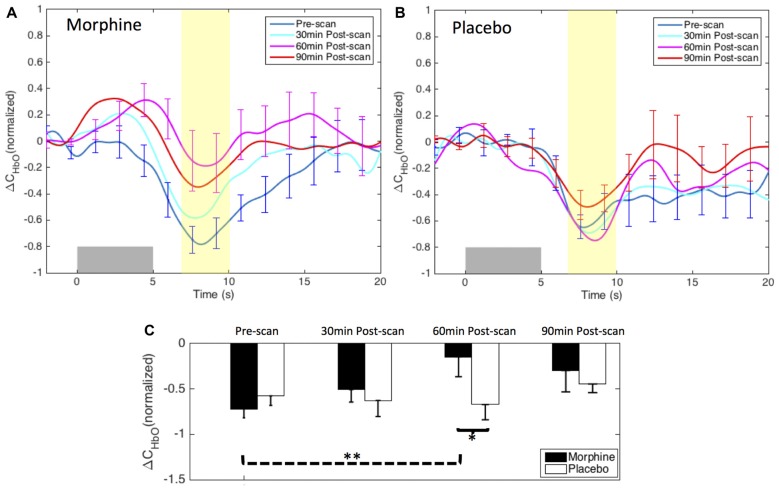
Morphine and Placebo effects on noxious stimuli in medial BA 10. Top panel: the normalized HRFs to noxious stimuli (VAS7) over the medial BA 10 during visits in which (A) oral morphine or (B) placebo was administered. Gray bars indicate the time period when noxious electrical stimuli were applied. Bottom panel: (C) bar plots of the averaged HRF magnitudes (from 7 s to 10 s post-stimulus) in each scan session. P-values showing statistically significant attenuation in the averaged magnitudes are marked in the figure, *p < 0.05, **p < 0.01. All error bars show the standard error of the mean. For image clarity, only the error bars of the pre-scan HRFs and the HRFs showing the most significant changes are depicted.